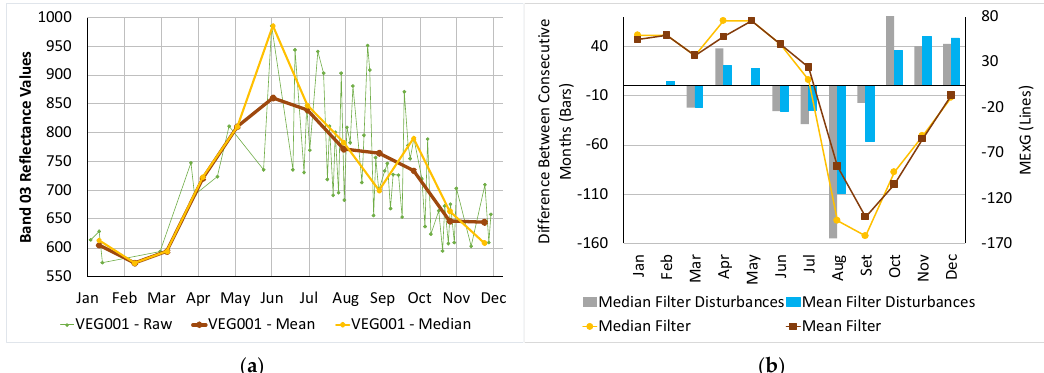
Figure 10. Comparison of mean and median noise reduction filtering ( a ) Raw and filtered data (band 03, Serra dos Candeeiros in 2017); ( b ) Month disturbances (MExG, Fundão in 2017).